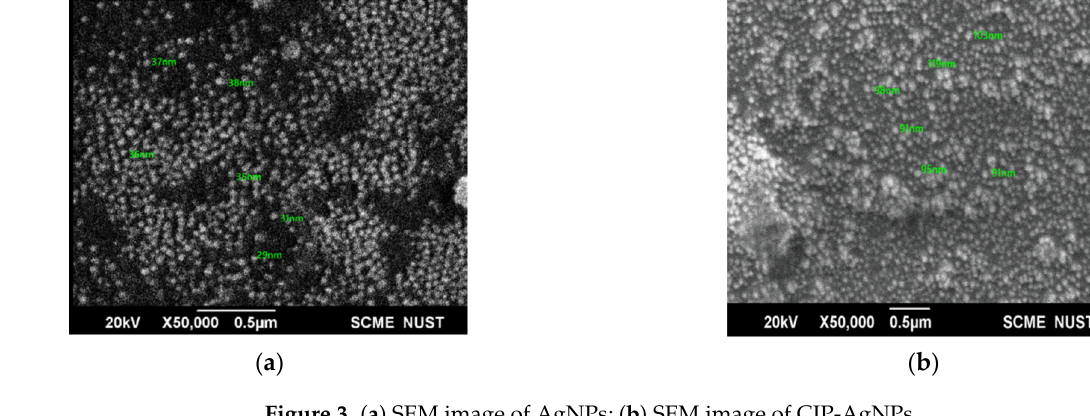
Figure 3. ( a ) SEM image of AgNPs; ( b ) SEM image of CIP-AgNPs.